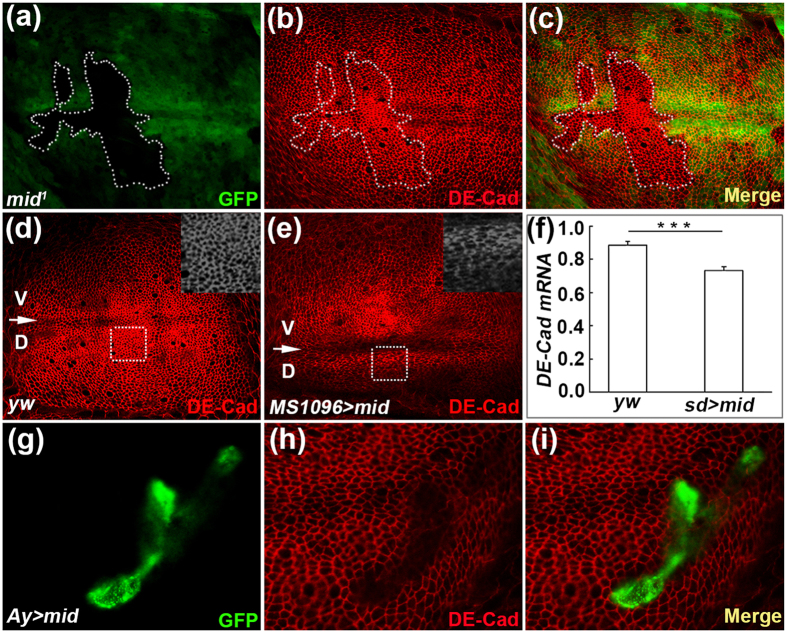
Mid represses the expression of DE-Cad.(a–c) DE-Cad expression is activated in a mid mutant clone (mutant clone lack GFP signal and is marked by a broken line) induced in the DP cells of the wing disc. The wing disc from a third instar larva of hs-FLP; FRT42D, Ubi-GFP/FRT42D, mid1 is stained with anti-GFP antibody (a), anti-DE-Cad antibody (b). (c) Merged image of (a,b). (d,e) The expression of DE-Cad in the wing disc of wild type (d) and sd-Gal4; UAS-mid (e). The DV boundary is marked by an arrow. Insert in (d) is magnification of the region marked by a white broken line to show normal apical cell shape. Insert in (e) is magnification of the region marked by a white broken line to show slender apical cell shape. (f) qPCR analyses of DE-Cad mRNA level in yw and sd > mid. Error bar, SEM from three independent experiments. Student’s tests, ***p < 0.001. (g–i) Somatic clone overexpressing Mid display downregulation of DE-Cad (clone is marked with GFP signal). The wing disc is stained with anti-GFP antibody (g), anti-DE-Cad antibody (h). (i) Merged image of (g,h).